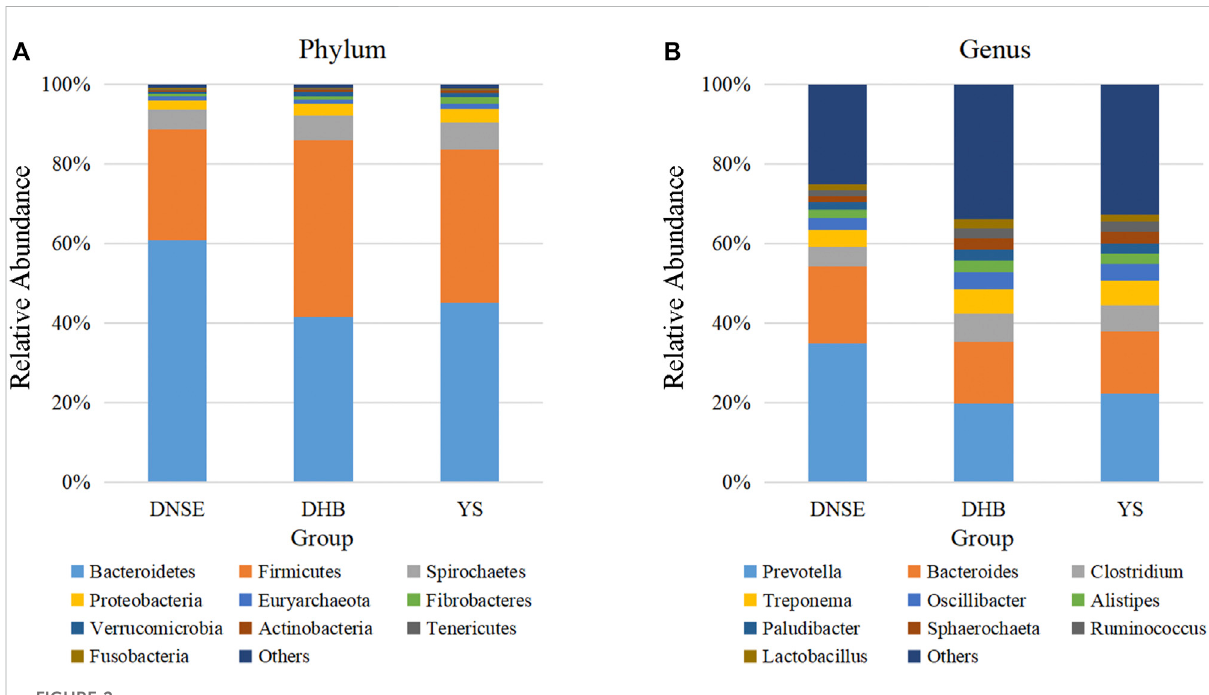
FIGURE 2 Gut microbial taxonomic composition at the phylum (A) and genus (B)